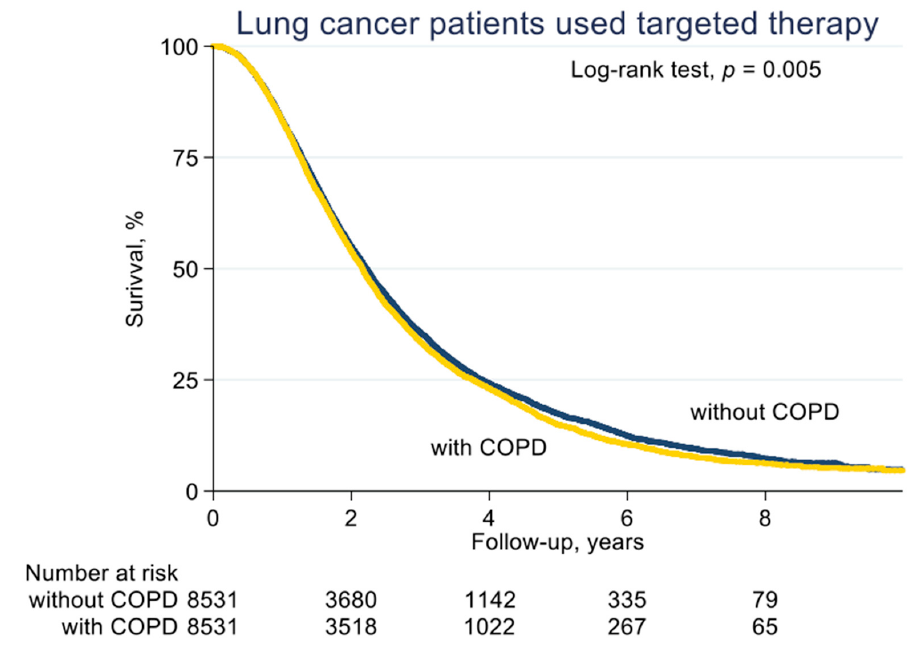
Figure 5. Overall survival curve of COPD and non-COPD cohorts (after PS matching).